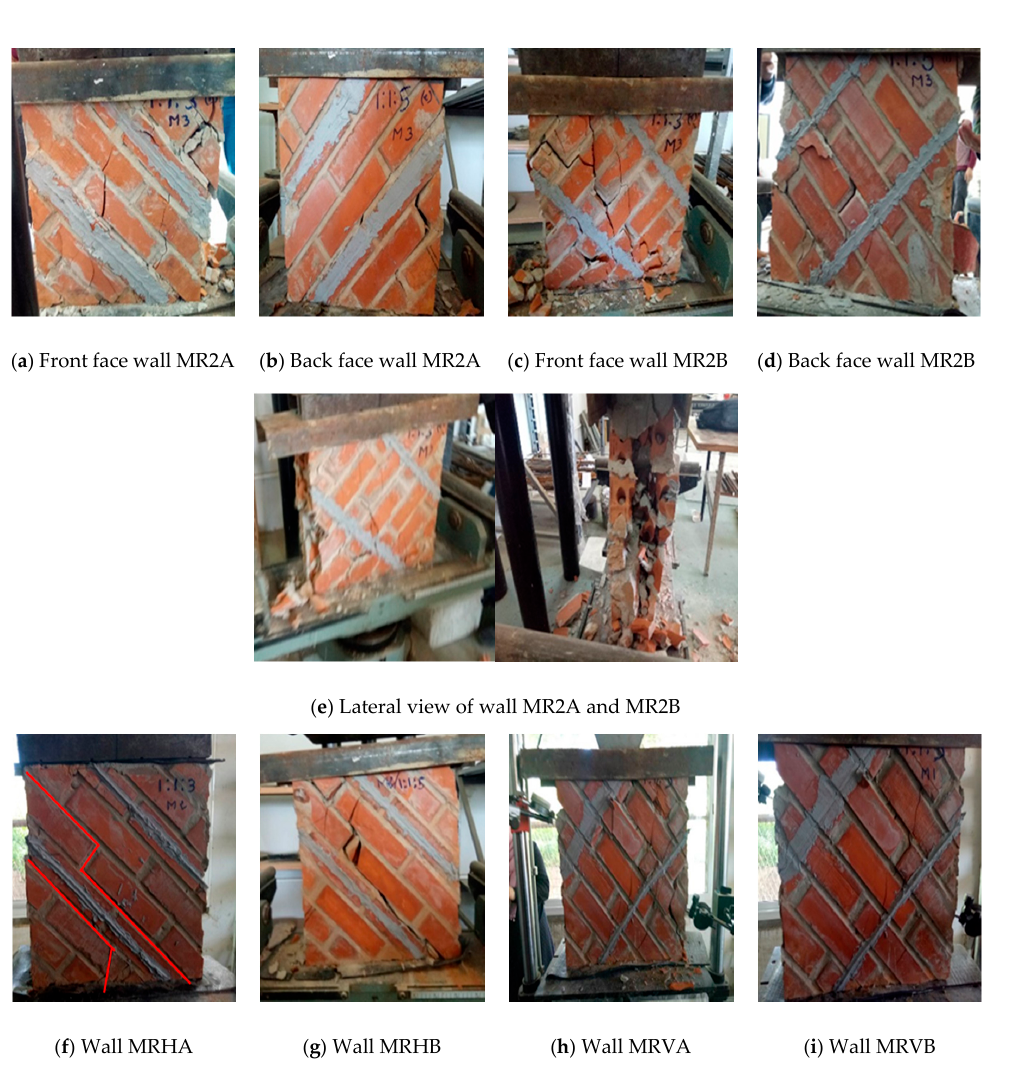
Figure 8. Shear stress–strain relationship for MRA and MRB reinforced masonry walls. 3.3. FEM Modeling for Unreinforced Masonry Wall (MTB) 3.3.1. Material Parameters In this study, the FE software ABAQUS was used to evaluate the validity of Detailed Micro- Modeling (DMM) as a numerical model for brick masonry wall analysis. The units and mortar joints are modelled using eight-nodded 3D continuum elements with hourglass control and reduced integration (C3D8R), and the unit-mortar interface with zero thickness. The penalty friction formulation was introduced to model tangential behavior with a friction coefficient value of 0.6. The normal behavior of the interface was modeled using “hard contact”. Furthermore, the nonlinear behavior of brick and mortar was simulated by using the CDP model while the interface between unit and mortar was modeled through surface-to-surface contact. The adopted modeling strategy used in this study is illustrated in Figure 9. Figure 9. Adopted detailed micro-modeling (DMM) approach.